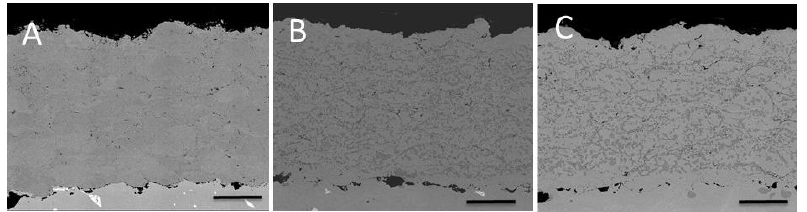
Figure 7. SEM micrographs for the HVOF sprayed CoNiCrAlY + heat treatment at 0 h ( A ), 500 h ( B ) and 1000 h ( C ) of isothermal test. Scale bar 50 μ m.